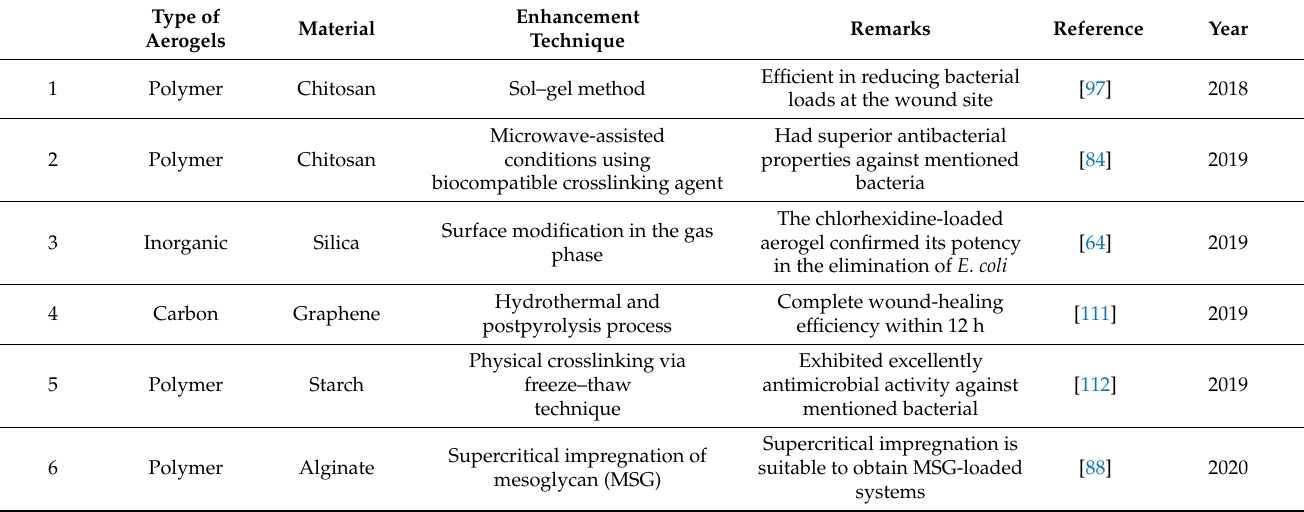
Table 3. Previous studies on wound healing and antimicrobial activity for various types of